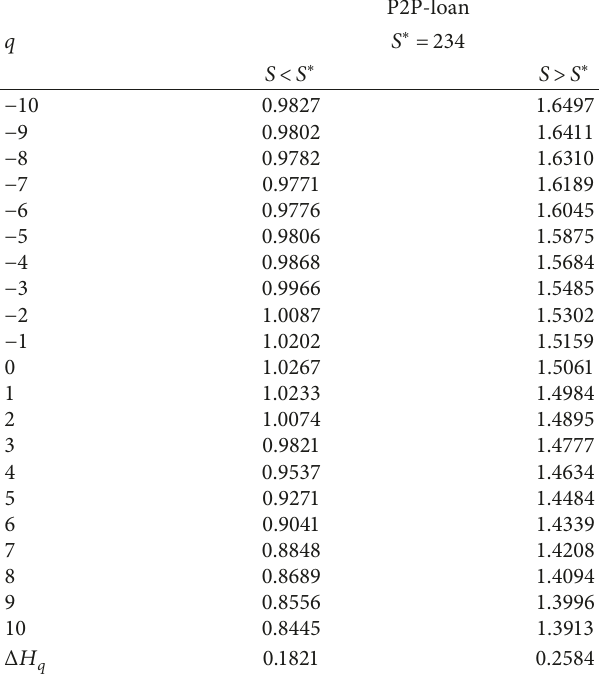
( q ) for P2P-loan xy